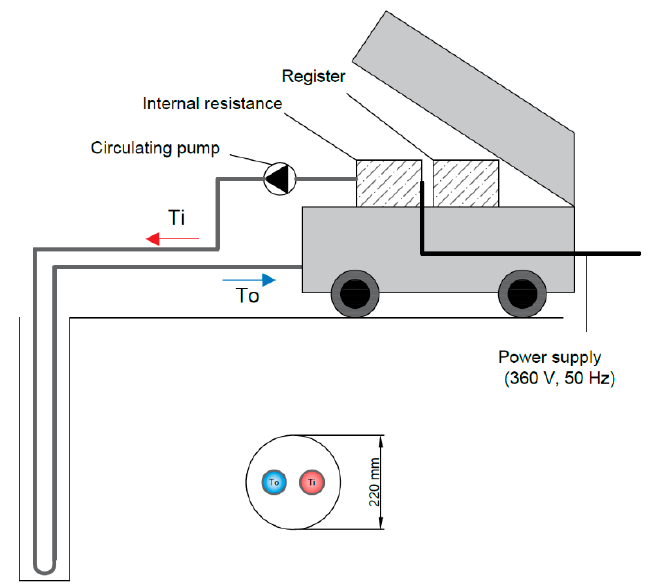
Figure 2. Schema of the TRT device in the borehole under study.